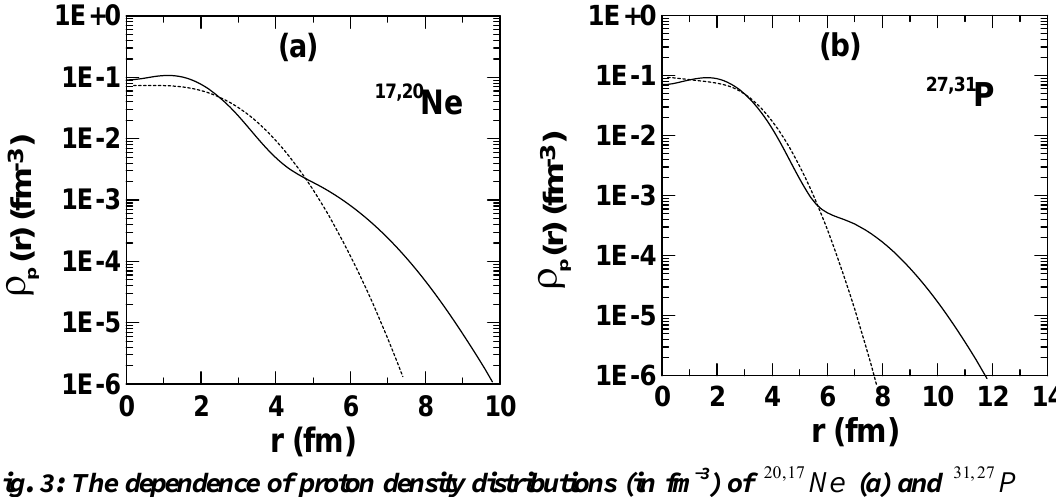
Fig. 3: The dependence of proton density distributions (in fm -3 ) of (b) on r (in fm). In (a) and (b), the solid lines are the proton density distributions of and whereas the dashed lines are those of stable